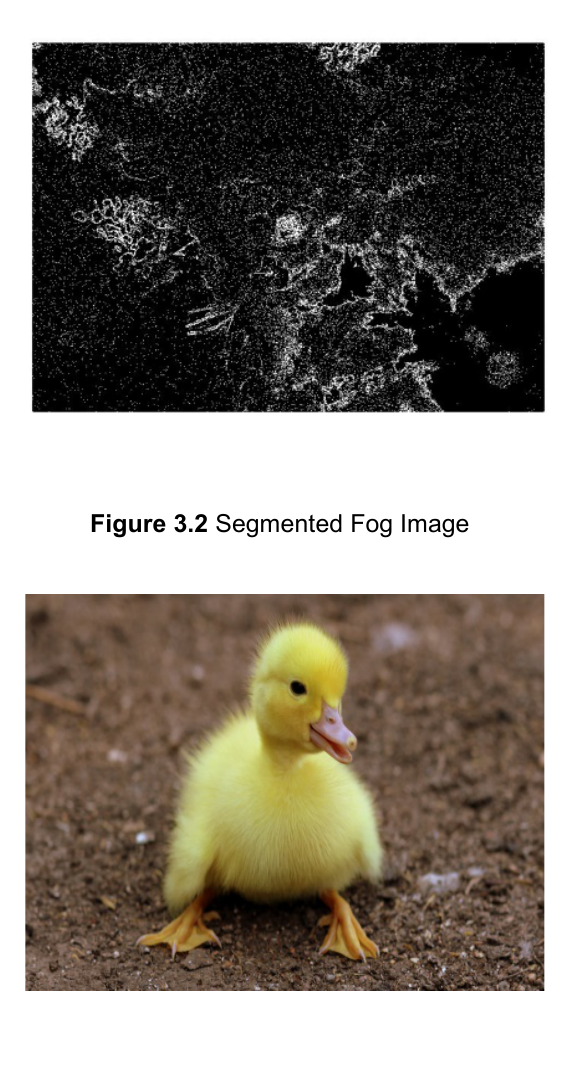
Figure 4.1 Duck